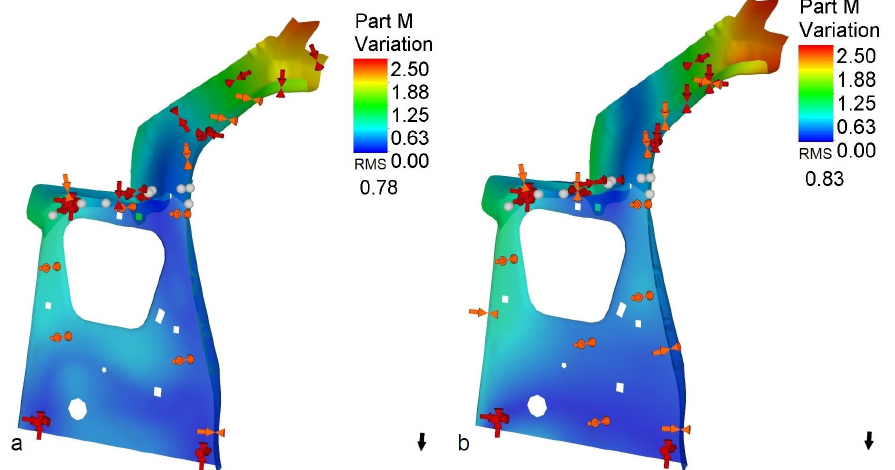
Figure 7. Color coded variations (six times the standard deviations) of the assemblies: ( a ) Simultane- ous production strategy and fixture layout optimization, relative production cost: 2.25. ( b ) Utilizing the highest quality production strategy after optimization of fixture layout, relative production cost